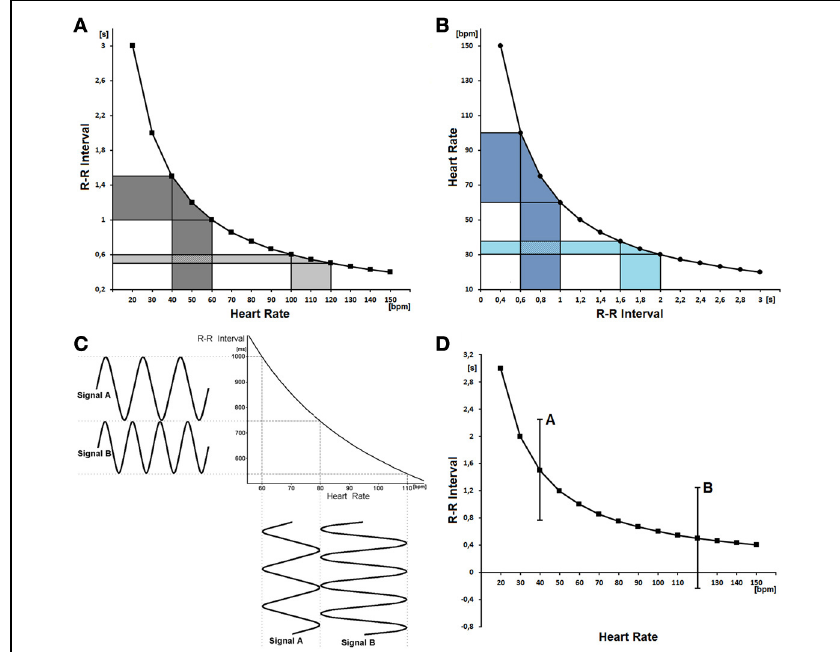
FIGURE 1 | (A) The non-linear (mathematical) relationship between R-R interval and heart rate is depicted. One can see that the oscillations of a slow average heart rate ( x -axis, dark gray area) result in much greater oscillations of RR intervals ( y -axis, dark gray area) than the same oscillations of a fast average heart rate (light gray area). As a consequence, the variability of R-R intervals is higher for the slow average heart rate than for the fast one, despite the fact that the variability of heart rate is the same (reprinted with modification from Sacha and Pluta, 2008). (B) The relationship between heart rate and R-R interval is shown—the same oscillations of R-R intervals yield much greater oscillations of HR for the fast average heart rate (dark blue area) than for the slow one (light blue area). Consequently, the variability of HR is higher for the case with fast average heart rate, despite the fact that the variability of R-R intervals is the same in both cases. (C) The relationship between R-R interval and heart rate is depicted along with two signals oscillating in different extents. Signal A oscillates between 60 and 80bpm but signal B between 80 and 110bpm. One can see that signal A is more variable (its amplitude is higher) than signal B when expressed as R-R interval signals, and conversely signal A is less variable than B if expressed as HR ones. The example clearly shows how the same signals may reveal an inverse relationship with each other depending on the way they are expressed (reprinted from Sacha and Pluta, 2005a). (D) The relationship between R-R interval and heart rate with two hypothetical examples of R-R interval oscillations (i.e., A and B) are presented. It is shown that the fluctuations of R-R intervals may be potentially quite high for a slow average HR (A), however, such fluctuations are not possible for a fast average HR (B) since the R-R intervals should have become